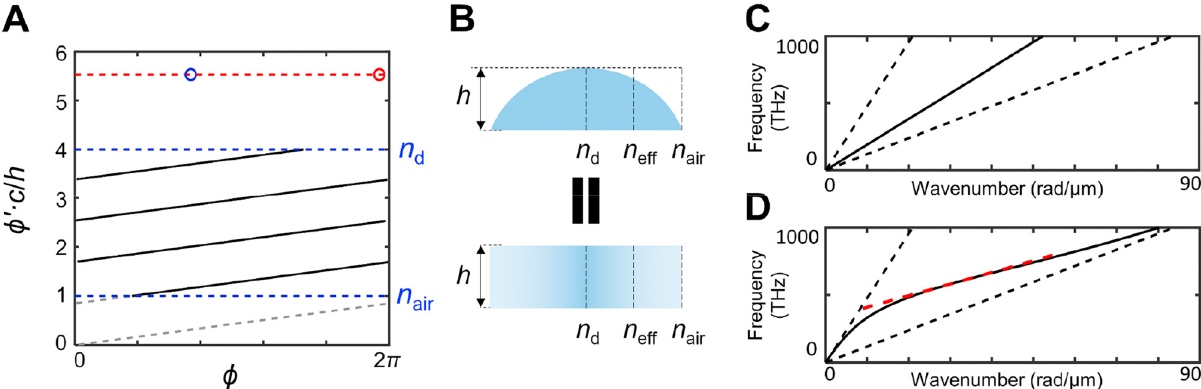
Figure 11: ϕϕ ′ -plane.(A) Concept of ϕϕ ′ -plane.Black line segmentsshow all possiblecombinationsof ϕ and ϕ ′ forconventionallensesmade of dispersion-less dielectric materials with refractive index between n air (= 1) and n d (= 4), when the thickness is h = 7.54 c / ω (600 nm). Gray dashed line segments are guide for the eye. Blue dashed lines show the lower and upper bounds of thickness-normalized ϕ ′ imposed by n air and n d . Red circle is the point corresponding to the dispersion represented by a red dashed line in Figure 11D. Blue circle corresponds to a different phase but the same fi rst derivative with that of red circle. Red dashed line shows all points with the same ϕ ′ c / h as the red circle and canbeimplementwiththesameunitstructurewithproperrotationifgeometricphasesareutilized.(B)Schematicsofaconventionallens(top) anditsequivalentgradientindexlens(bottom).(C)Dispersionrelationofaquasi-staticcompositemediummadeofdispersion-lessmaterials. Two dashed lines are light lines of component materials. (D) An example of dispersion relation of metamaterial. Red dashed line is a tangent line to the dispersion relation at the target frequency of 600